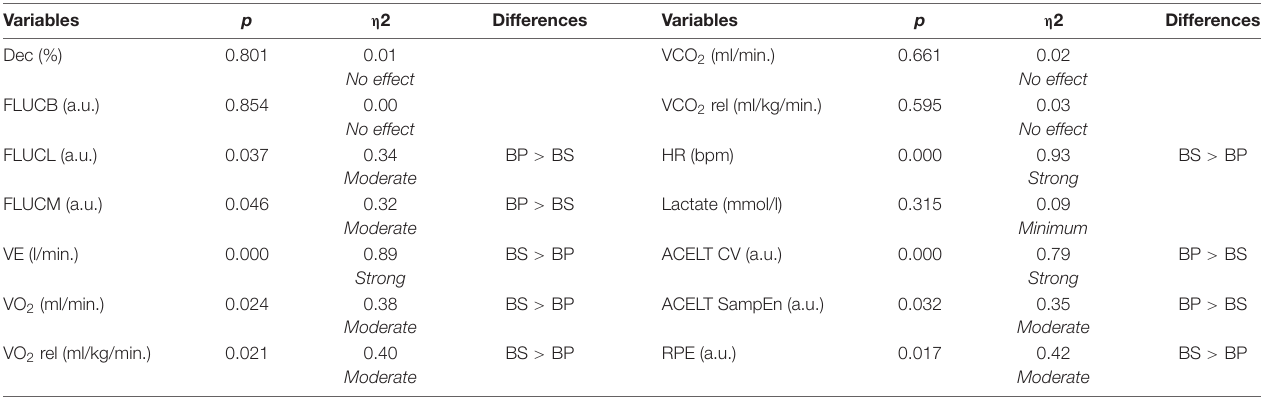
TABLE 3 | Comparison between parallel Back Squat and Bench Press protocols. Variables Differences Differences